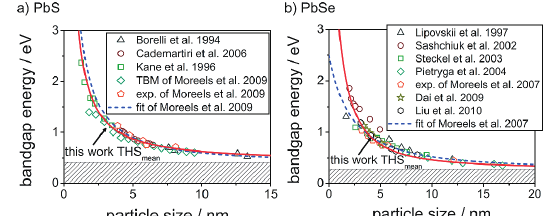
Fig. 9 Relationship between fundamental band gap energy and particle size as derived in this work along with comparison to literature data for a) PbS (Borrelli N.F. and Smith D.W., 1994; Cademartiri L. et al., 2006; Kane R.S. et al., 1996; Moreels I. et al., 2009) and b) PbSe (Dai Q. et al., 2009; Koole R. et al., 2008; Lipovskii A. et al., 1997; Liu Y. et al., 2010; Ma W. et al., 2011; Moreels I. et al., 2007; Pietryga J.M. et al., 2004; Sashchiuk A. et al., 2001; Steckel J.S. et al., 2003) as indicated. Reprinted with permission from Segets et al., “Determination of the Quantum Dot Band Gap Dependence on Particle Size from Optical